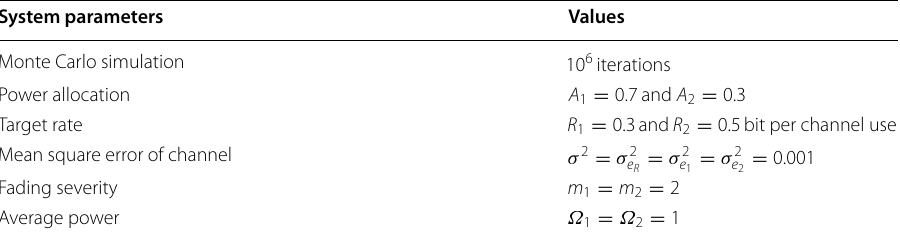
Table 4 Satellite link parameters Shadowing m R b R Ω R Heavy shadowing (HS) 1 Average shadowing (AS)